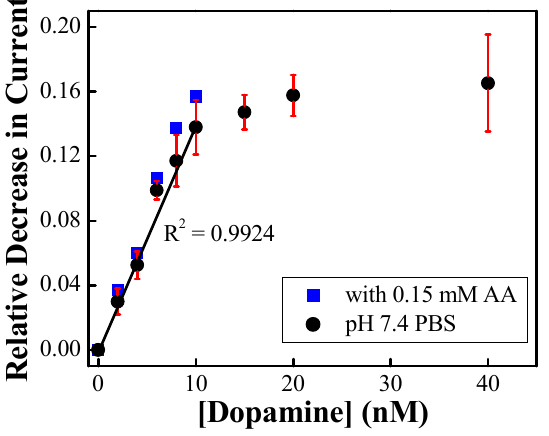
Figure 11 . Correlation curves for the detection of dopamine on the electrode modified with ss-DNA/SWNT/PABA/Nafion composite in the absence ( ● ) and presence ( ■ ) of 0.15 mM AA ( n =3) (Reproduced with permission from the American Chemical Society